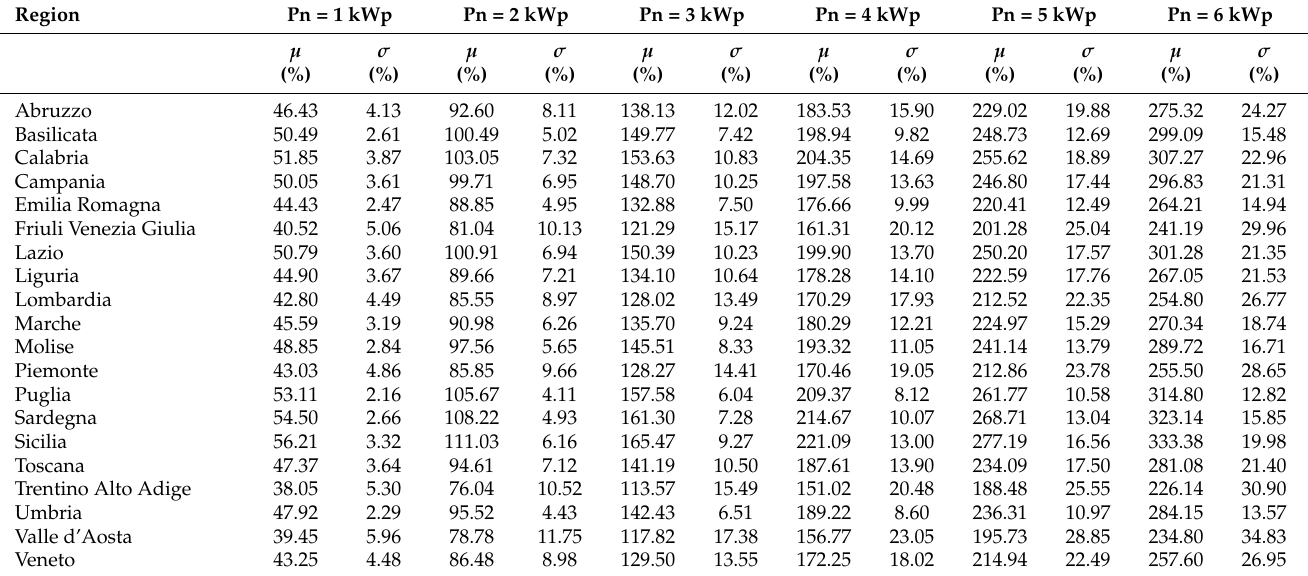
Table 10. CO 2 saving for E L = 2700 kWh with battery.